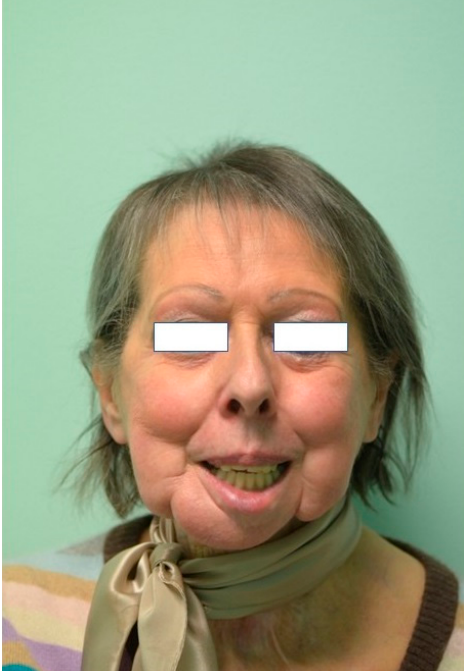
Figure 16. Computerized tomography (CT) after 2 years.